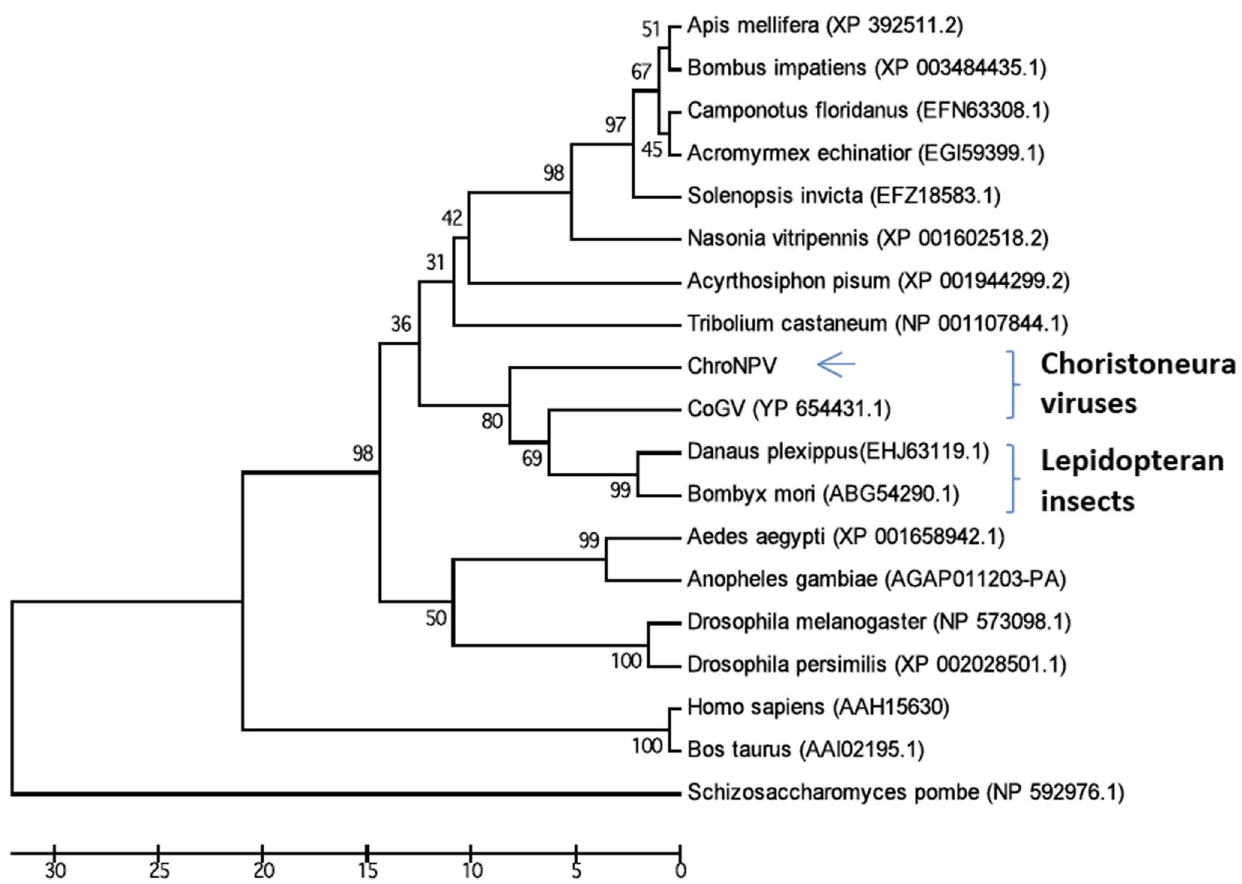
Figure 4. Phylogenetic tree for eukaryotic initiation factor 5 (eIF-5). Homologues of ChroNPV eIF-5 were obtained from NCBI database using BLASTP. The tree was generated based on concatenated amino acid sequences of ChroNPV eIF-5 and of other eukaryotic organisms available in the database. GenBank accession number for some analyzed taxa is shown beside those taxa. The analysis was conducted in MEGA 5 [41] and inferred using the UPGMA method [42]. The bootstrap test values (1000 pseudo-replicates) are shown next to the branches [43].